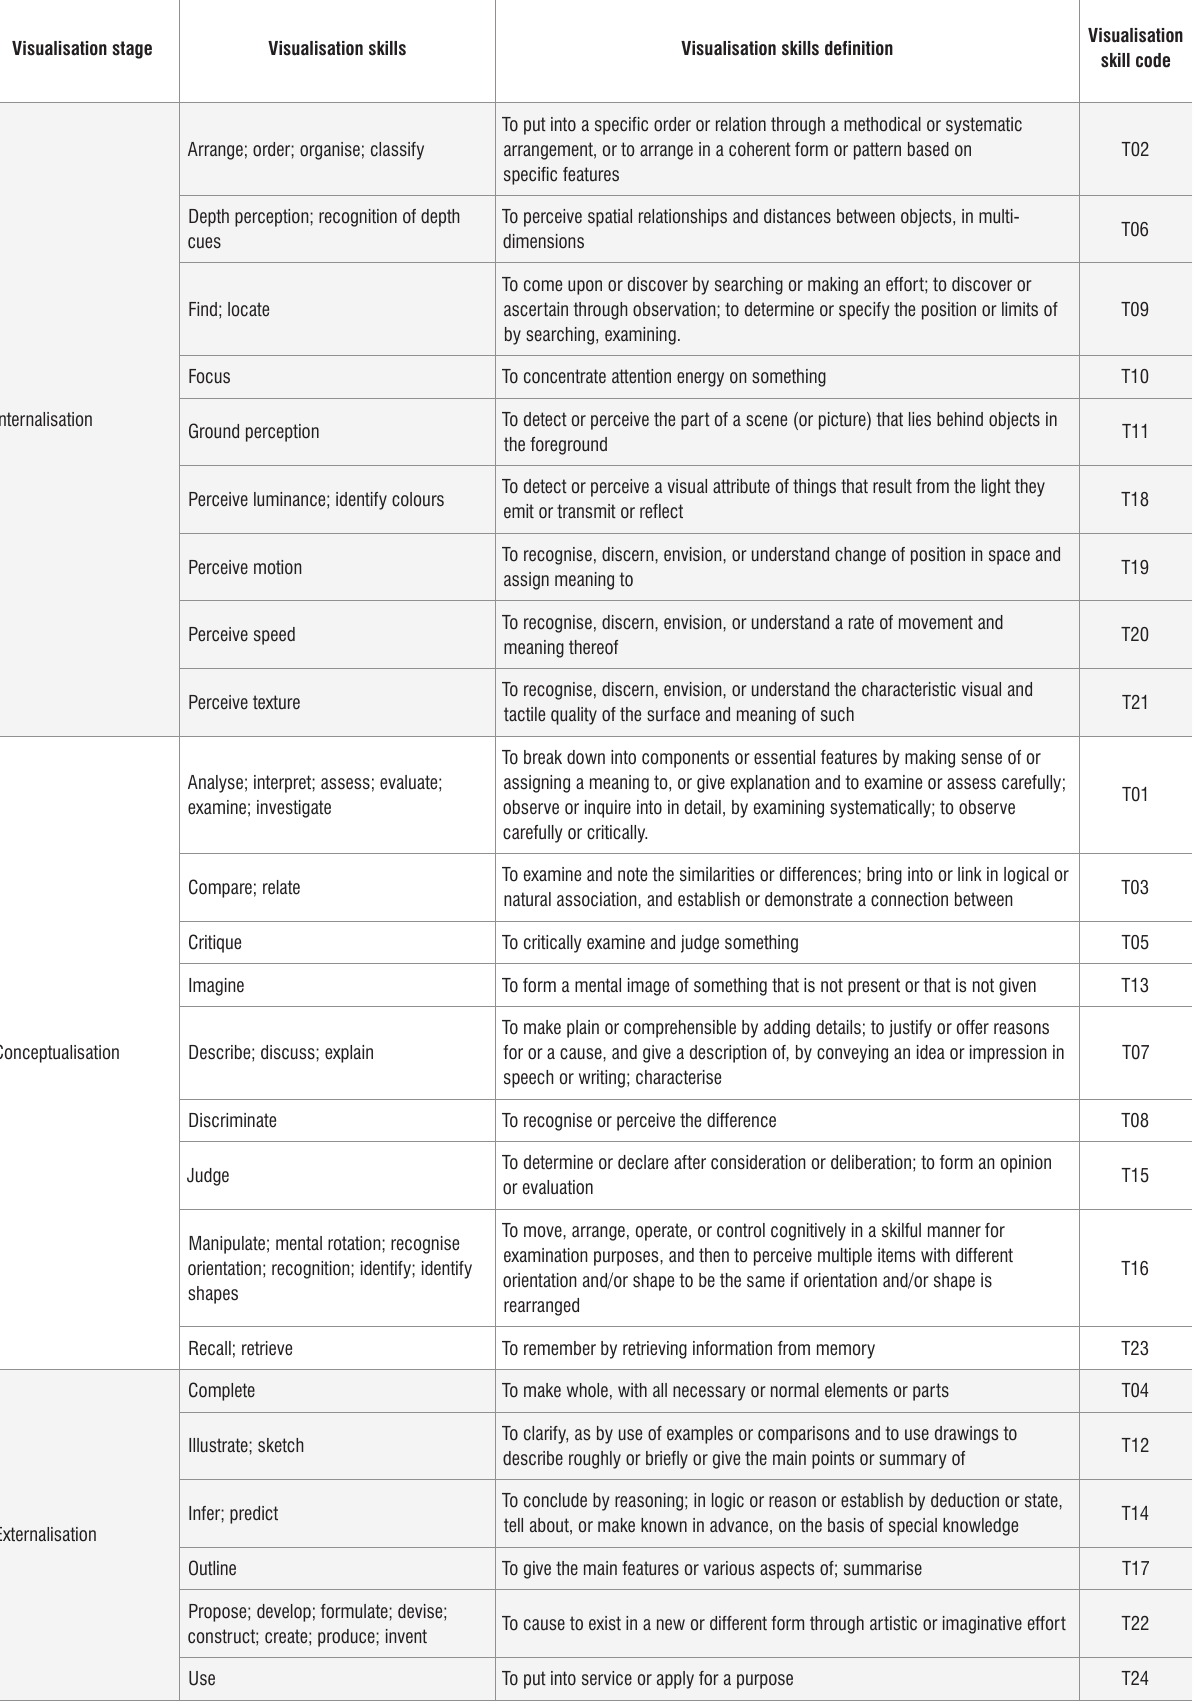
Table 1: List of visualisation skills required for visual literacy